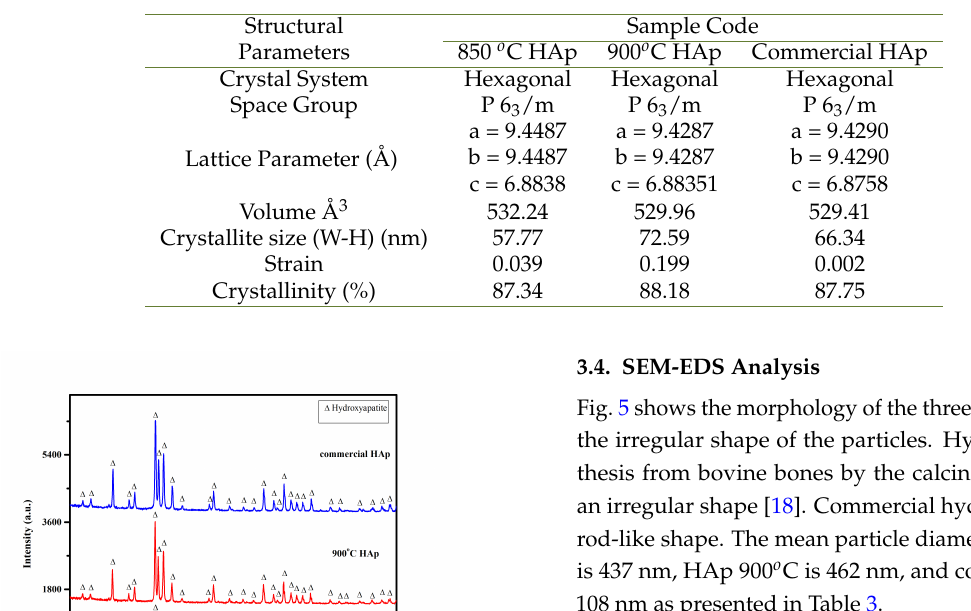
Table 2. Hydroxyapatite crystallographic parameters of calcined bovine bone samples at 850 o C, 900 o C, and commercial HAp.